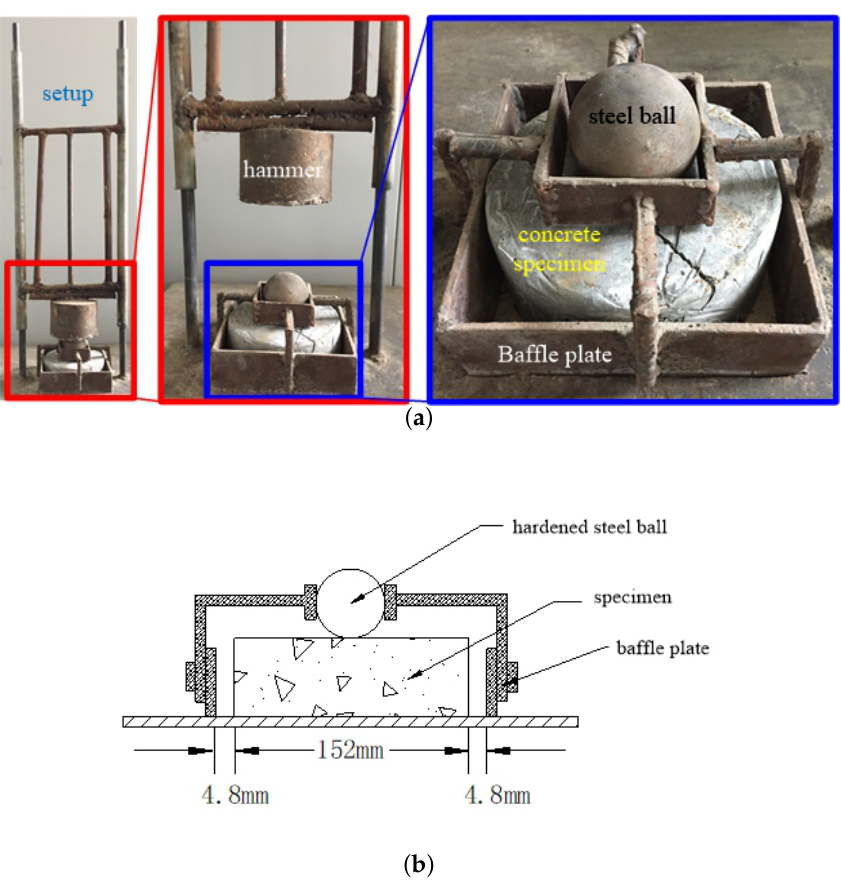
Figure 4. Drop weight test device. ( a ) Setup photo in different views; ( b ) Cross-section view of the disc